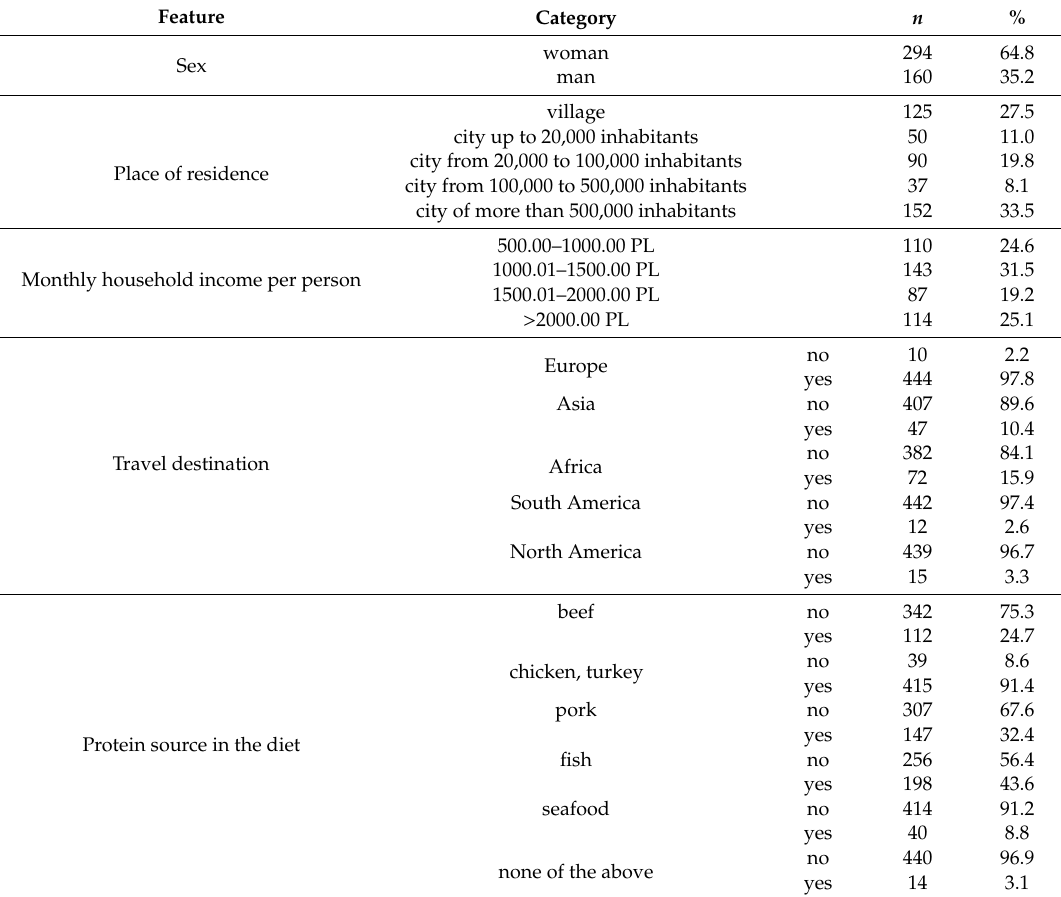
Table 1. Consumer demographics